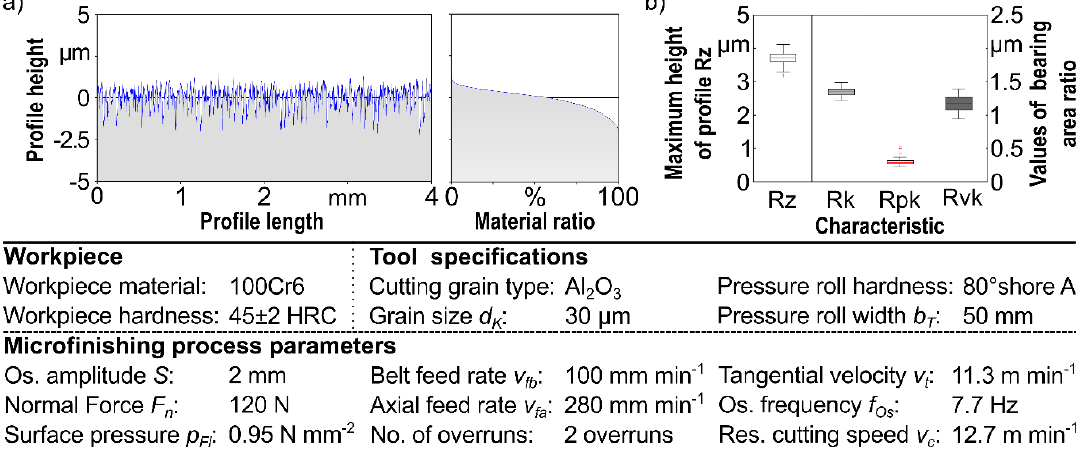
Figure 7. Resulting surface for the first rough microfinishing step by means of ( a ) the profile and material ratio curve and ( b ) surface values. J. Manuf. Mater. Process. 2019 , 3 , x FOR PEER REVIEW